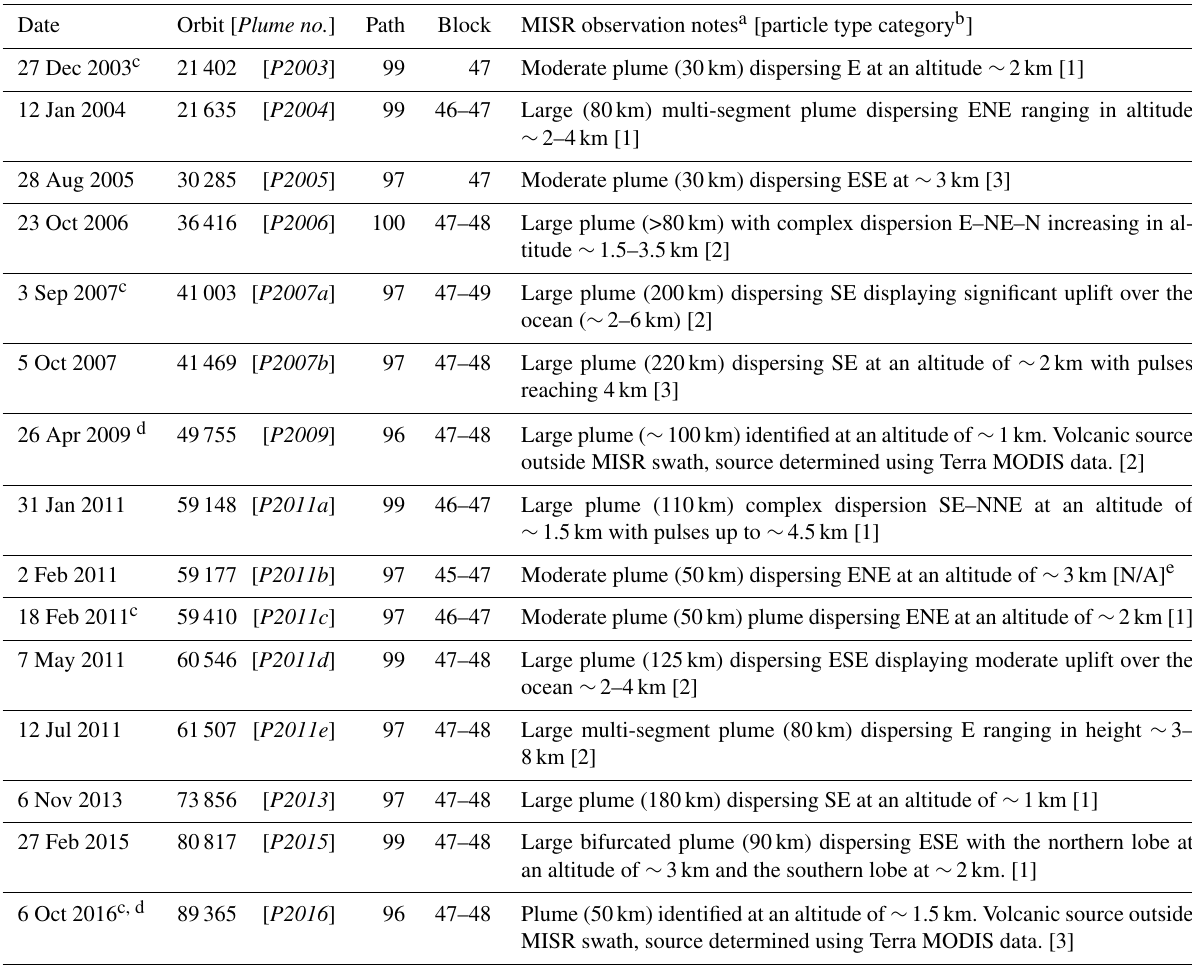
Table 1. MISR observed volcanic plumes from Karymsky during the study period (2000–2017). Date Orbit [ Plume no. ]